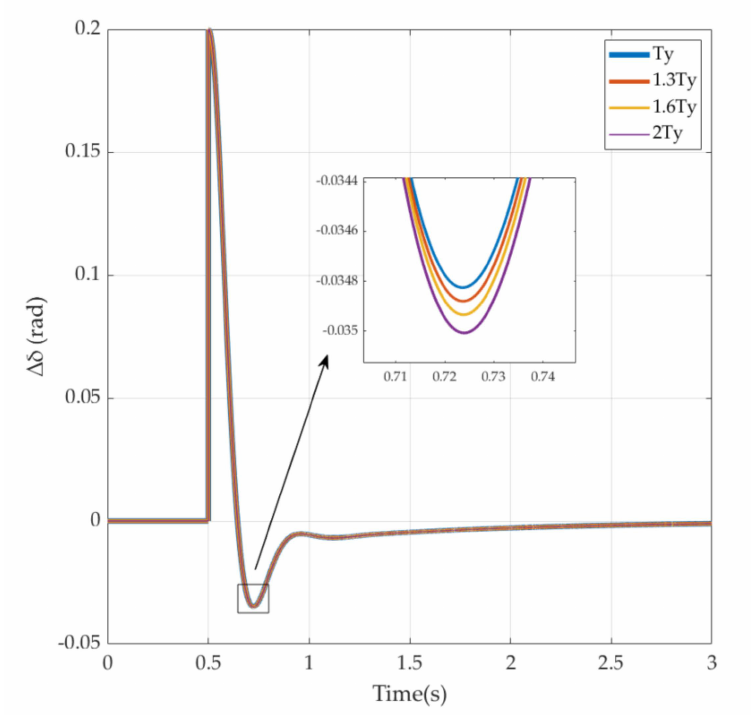
Figure 21. The control effect of the controller when T y changes ( ∆ δ − t ) .